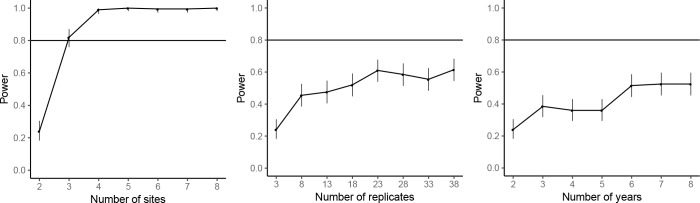
Power analysis results for rice leaf roller occurrence.See caption of Figure 7—figure supplement 1 for details.